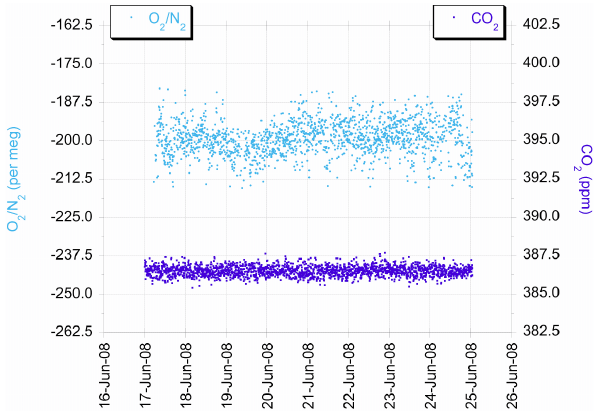
Fig. 4. Measurements of δ O 2 /N 2 (lighter circles) and for CO 2 (darker squares) during a laboratory test run of the measurement system. Both y -axes have been adjusted so that their ranges are nearly the same on a molar basis.